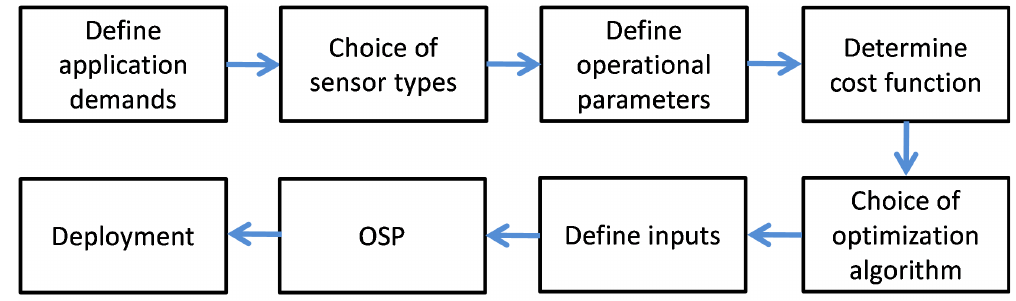
Figure 2. Framework of the optimization of sensor placement (OSP) problem